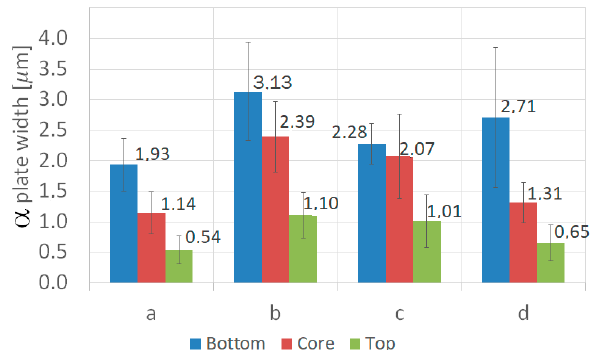
Figure 8. Average width of α -plates in the three regions across the thickness of the a – d sample disks.